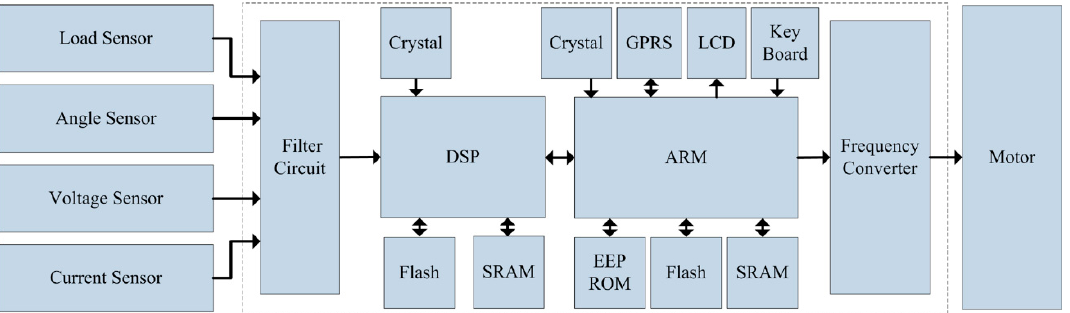
Figure 3. Functional block diagram of the controller.